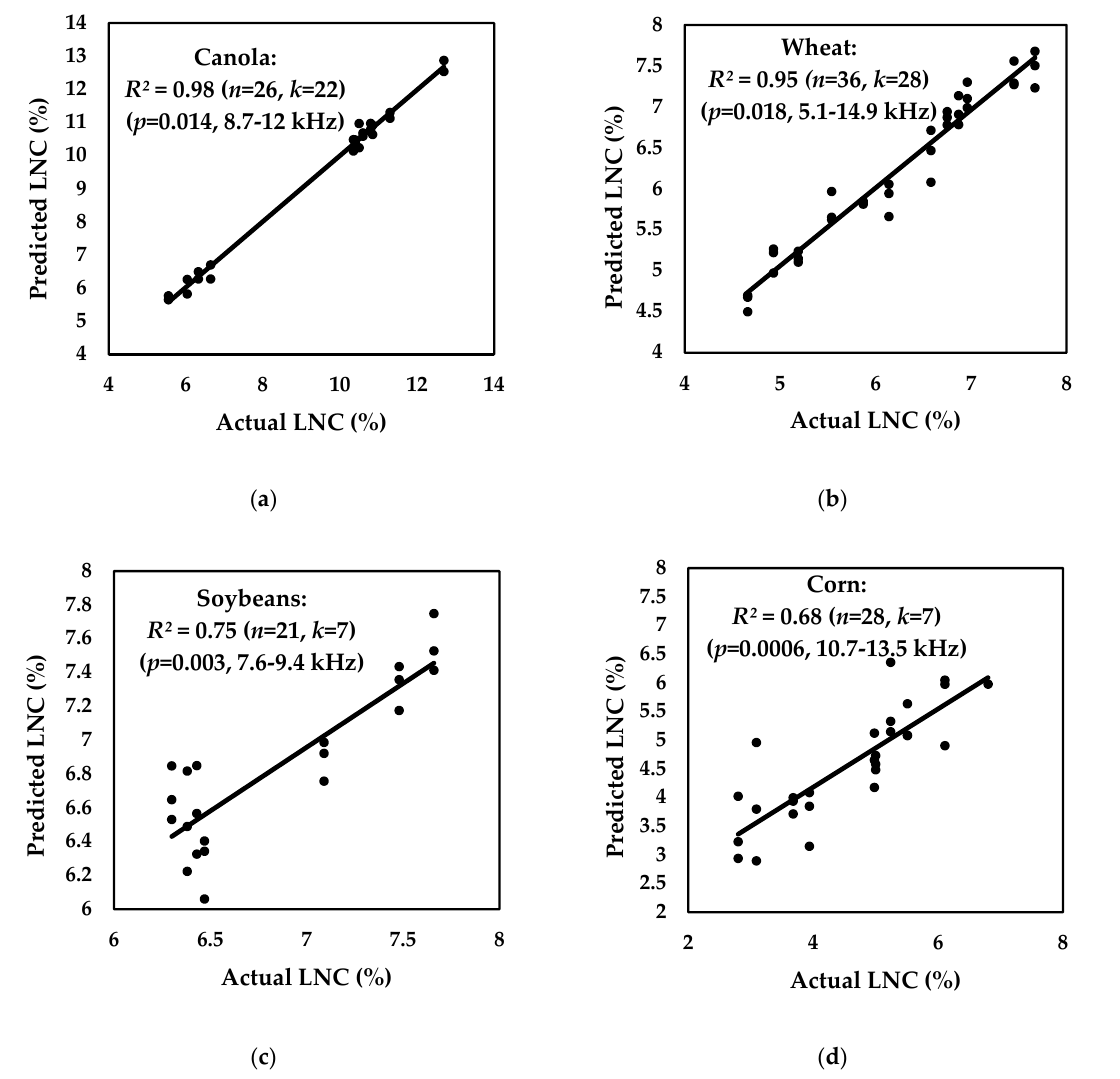
Figure 5. Multiple regression analysis for ( a ) canola; ( b ) wheat; ( c ) soybeans; and ( d ) corn. The extracted coefficient of determination ( R 2 ) is for canola 0.98, for wheat 0.95, for soybeans 0.75, and for corn 0.68.